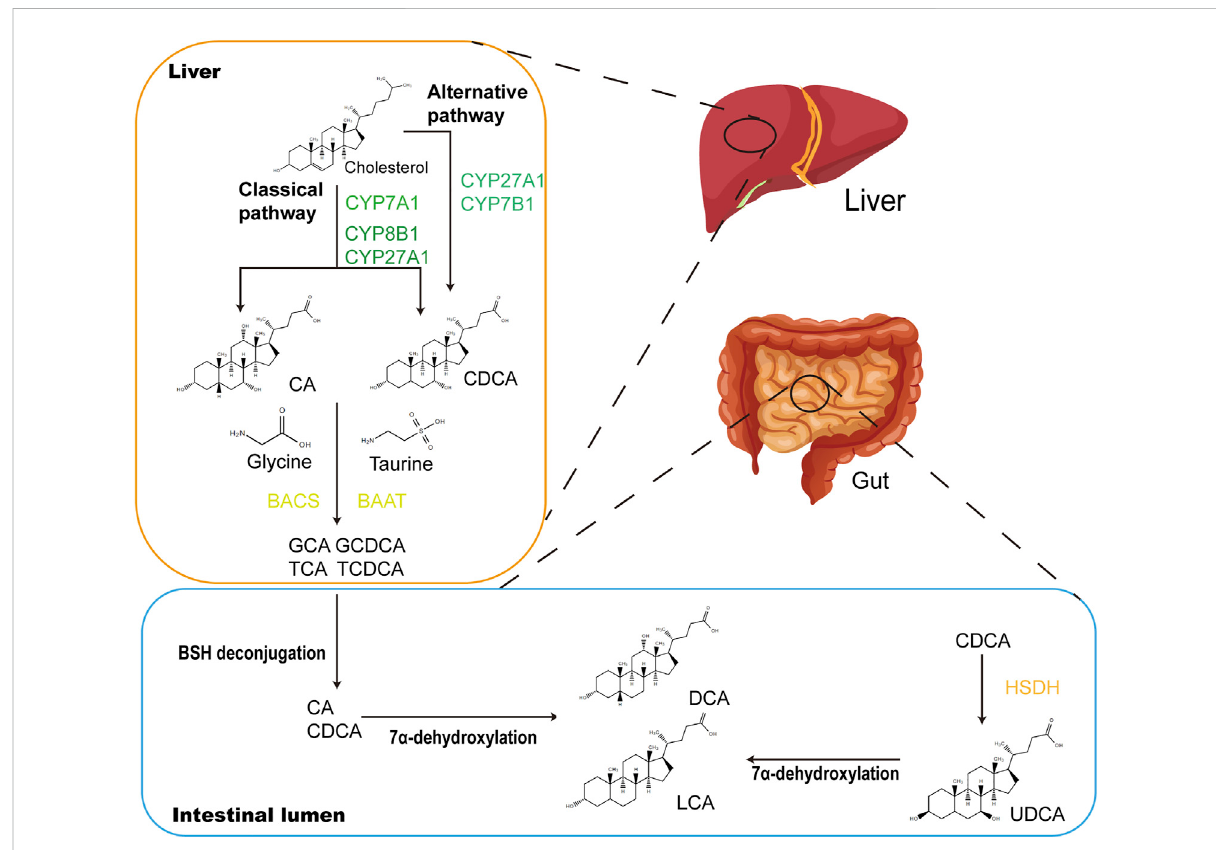
FIGURE 2 CDCA biosynthetic and metabolicpathways.In theliver, CDCA are synthesized fromcholesterol via oxidation catalyzedby CYPs, which occurs in the classical and alternative pathways. In theclassical pathway, CYP7A1converts cholesterol to 7 α -hydroxycholesterol, which is then transformed intoCAandCDCAthroughthesubsequentactionsbyCYP8B1andCYP27A1.Thealternativepathway isinitiated byCYP27A1andproducesCDCAby CYP7B1. Primary BAs CA and CDCA are amidated with glycine or taurine to form conjugated bile acids (GCA, GCDCA, TCA and TCDCA) under the actions of BACS and BAAT. When secreted into the gut after meals, conjugated bile acids are transformed into secondary BAs (LCA and DCA)